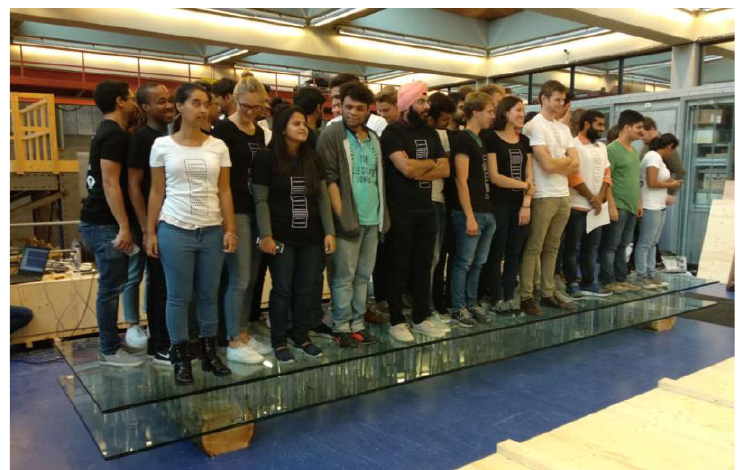
Fig. 14 Non-destructive test of large prototype panel using a static load exceeding the normal service